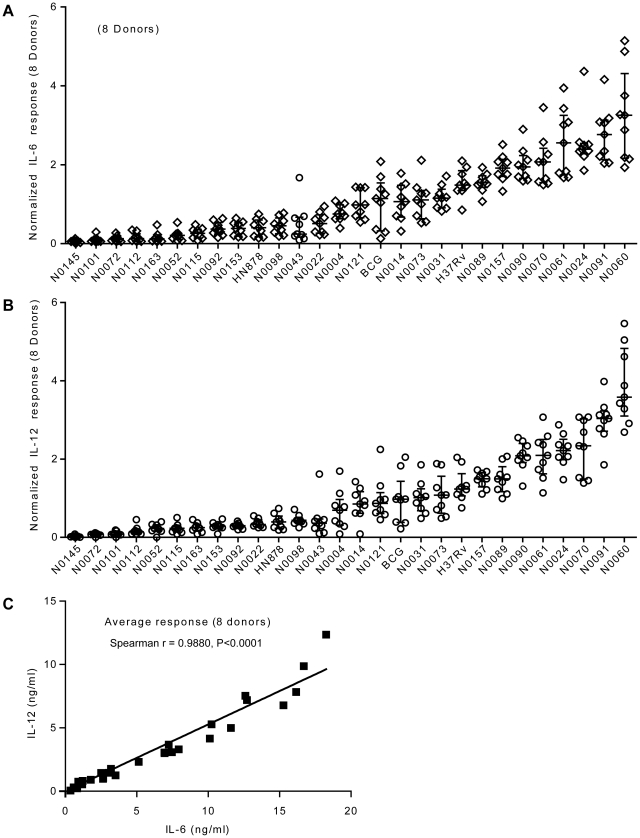
Strain-related hierarchy in pro-inflammatory response is maintained across multiple human donors.
A) Scatter plot representation of IL-6 and B) IL-12p40/p70 macrophage responses from eight different individual donors. Cytokine responses from each individual donor to a particular strain were normalized with respect to the median response of the donor towards the panel of strains. The response to each strain was ranked according to the average response across the eight donors. The results show that the hierarchy of IL-6 and IL-12p40/p70 response is maintained across independent donors. C) Linear regression analysis shows significant correlation between IL-6 and IL-12p40/p70 macrophage responses to the different strains used in the study. Correlation coefficient and p-value result from non-parametric correlation test (Spearman) are indicated on the graph.